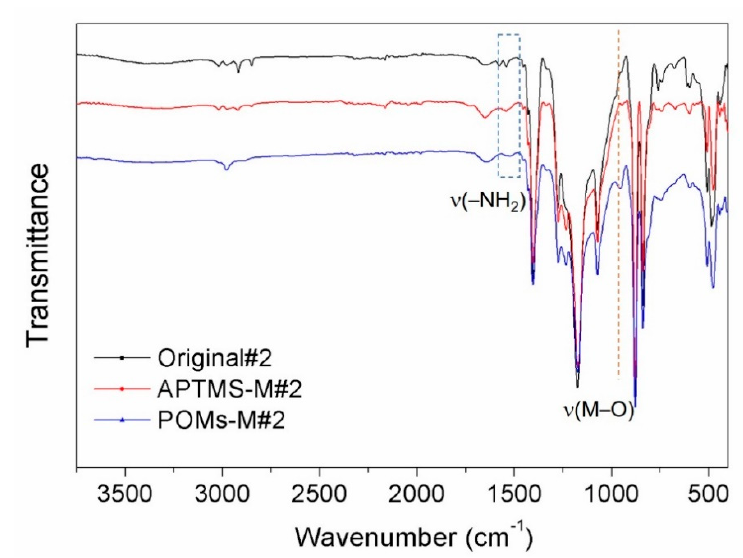
Figure 7. FTIR spectra of the original alumina / PVDF membrane (Orginal#2), the APTMS-treated membrane (APTMS-M#2), and the PWCo-modified membrane (POMs-M#2).